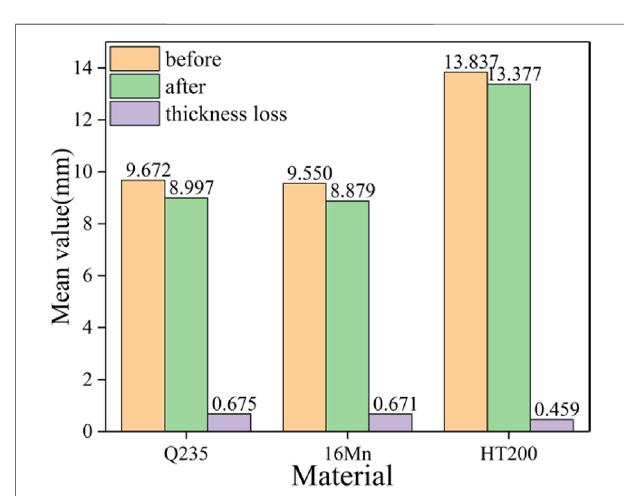
FIGURE 13 | Mean thickness value of different material blades at measuring